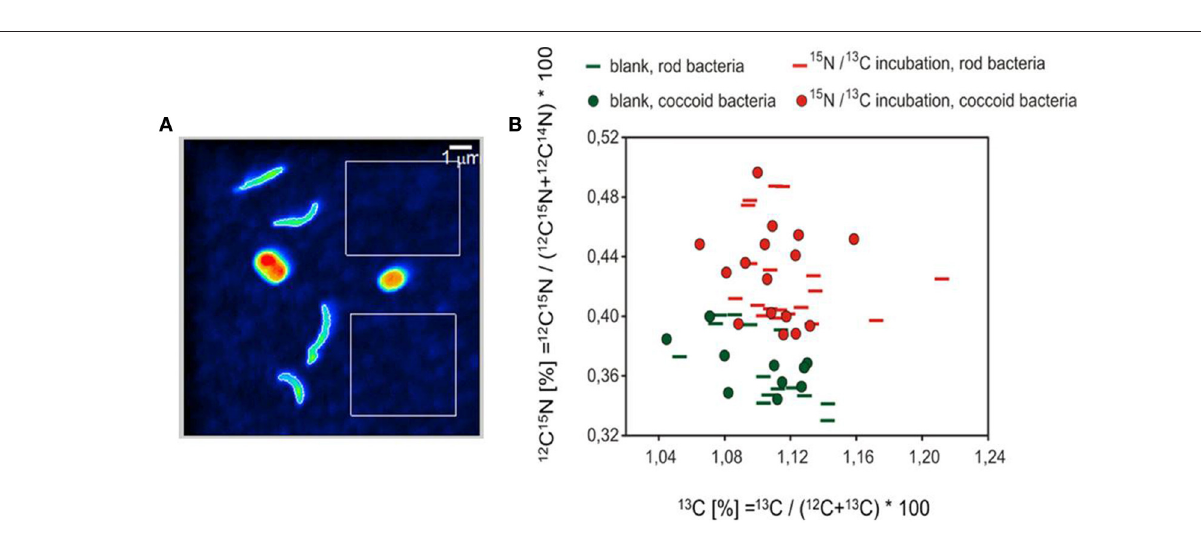
FIGURE 7 | NanoSIMS analysis. (A) 12 C 14 N image representing the cell structures used as the basis for definition of the region of interest (ROI). Please note that the color coding of the 12 C 14 N image does not indicate isotopic enrichment. The white rectangles represent areas for the determination of background values for the quality control of the measurements. (B) Isotopic values of coccoid and rod-shaped bacteria are illustrated according to their shapes. Green colored symbols denote the measured bacteria of the unlabeled blank sample, red symbols the bacteria of the 13 CH 4 and 15 NO 2